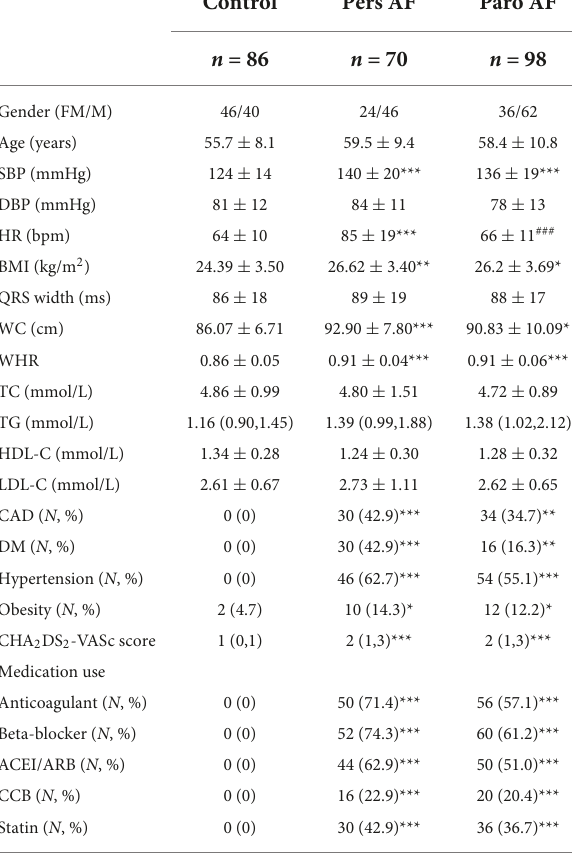
TABLE 1 Comparison of clinical characteristics among subjects with different types of AF. Control